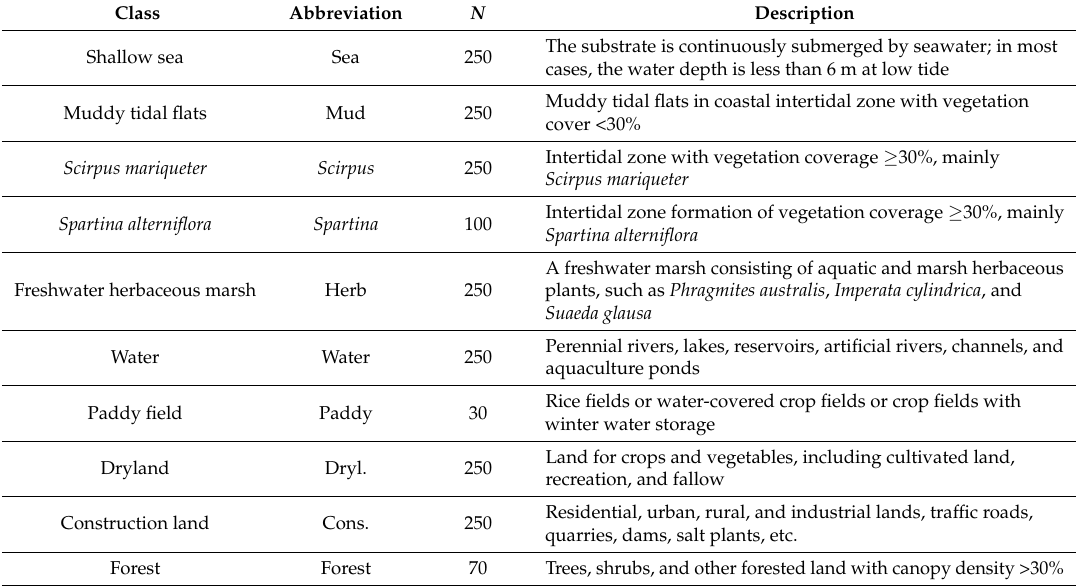
Table 1. Description of the designed land cover classification system in this research.